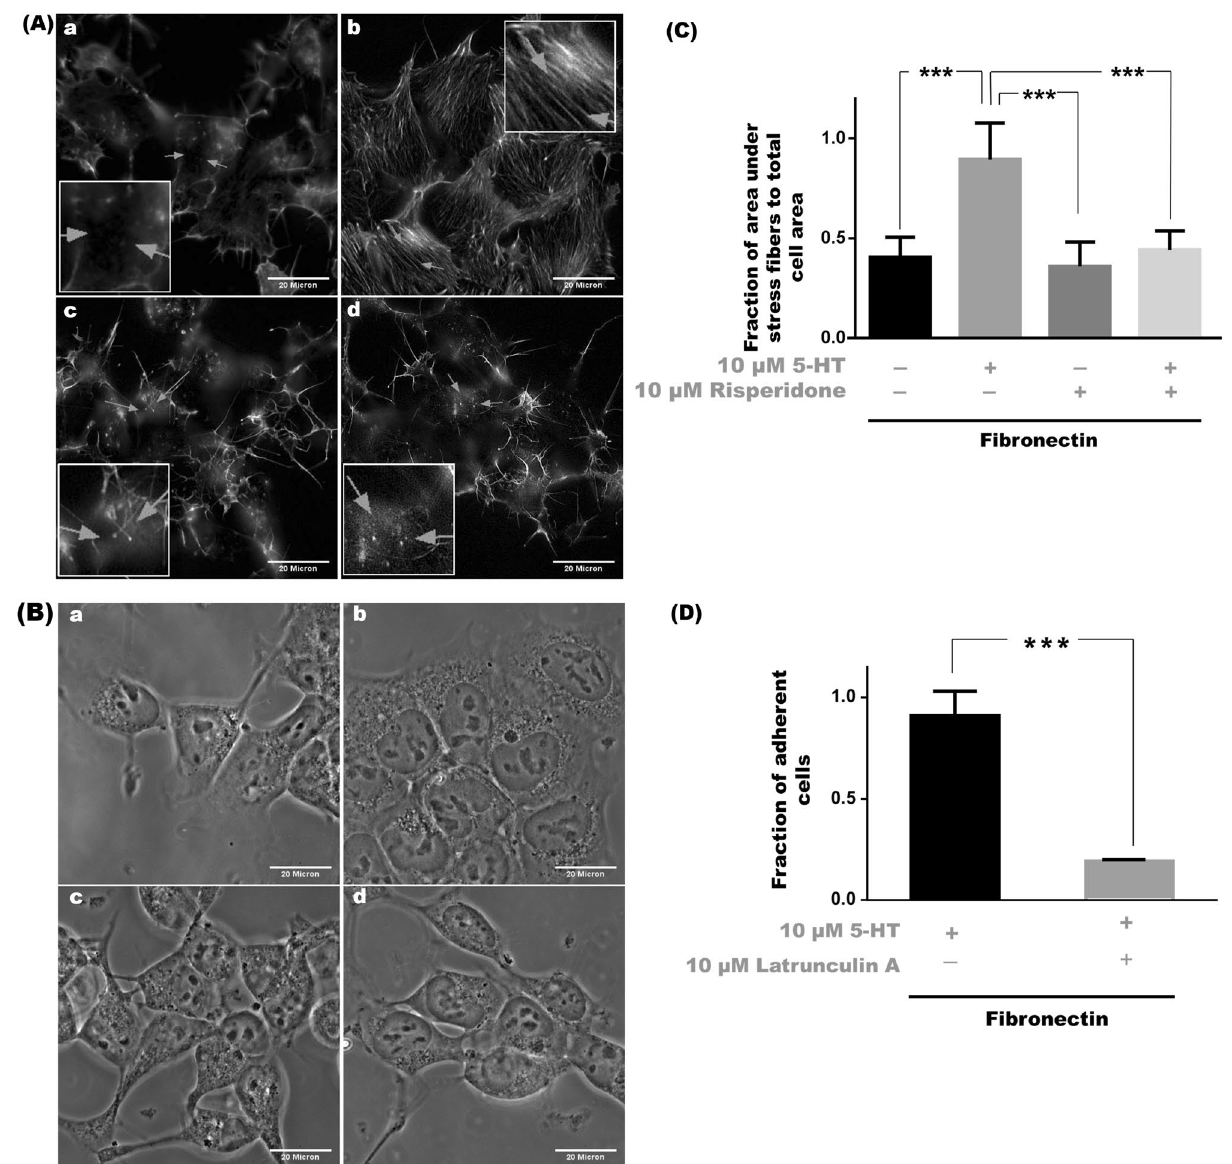
Figure 4. Stress fibers are modulated by the activity of 5-HT 2A in Hu 2A AB1 cells. ( A ) Stress fibers appear to be absent in untreated control cells ( a ) and appear on treatment with 10 μM 5-HT ( b ), they are no longer visible on treatment with 10 μM risperidone alone ( c ) or on treatment with 10 μM risperidone + 10 μM 5-HT ( d ). Stress fibers stained with Phalloidin Alexa 568 are seen as long structures indicated by the arrows. Scale bar represents 20 µm for all images. ( B ) The corresponding phase contrast images of cells stained with Phalloidin Alexa 568 in ( A ) are shown in ( a ), ( b – d ). Scale bar represents 20 µm for all images. ( C ) The fraction of area occupied by stress fibers by the total area occupied by cells with 10 μM 5-HT, 10 μM risperidone and a combination of 10 μM risperidone + 10 μM 5-HT treatment compared to untreated control. ( D ) Cell adhesion profile of Hu 2A AB1 cells treated with 10 µM 5-HT in the presence or absence of 10 µM latrunculin A on a fibronectin substrate. Error bars represent SD values. The data represented by the gray bars are compared against the respective black bars by two tailed students t test; p value less than 0.05 is considered significant. The corresponding p value for the asterisks is ***p < serotonin-mediated adhesion in Hu 2A AB1 and Rat 2A SB1 cells. While 10 μM serotonin alone caused 105 ± 7% and 93 ± 10% of cells to adhere respectively in the case of Hu 2A AB1 and Rat 2A SB1 cells, the presence of 10 μM W7 had negligible effect and 90 ± 8% of Hu 2A AB1 cells and 84 ± 3% of Rat 2A SB1 cells remained adherent. In contrast, in HEK293 cells, adhesion was reduced by W7 irrespective of the presence or absence of serotonin (Fig. 6B, Supplementary Fig. S4B). We found that a combination of 10 μM W7 and 10 μM serotonin treatment reduced cell-adherence to 20 ± 6% compared to cells treated with 10 μM serotonin alone which were 63 ± 12% (p < 0.01) adherent (Fig. 6B). In the absence of serotonin only 20 ± 2% of the 10 μM W7 treated HEK293 cells remained